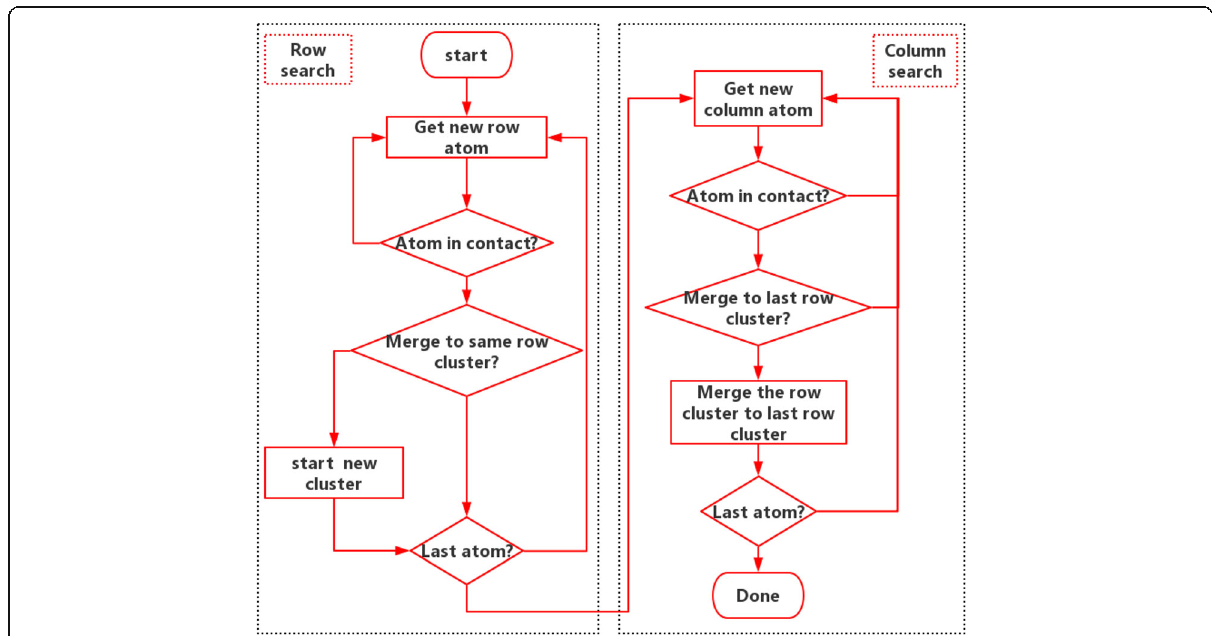
Fig. 2 Contact cluster detecting algorithm: the labeling